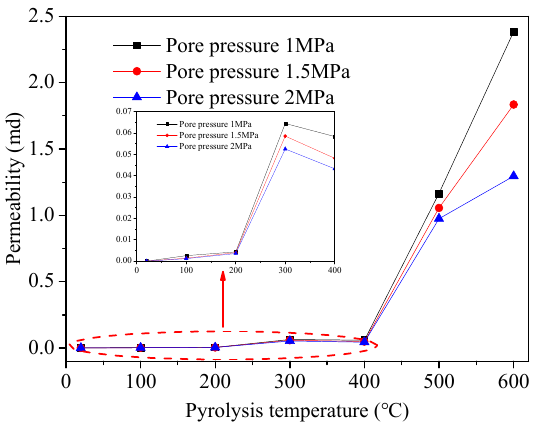
Figure 10. Correlation between permeability and temperature.